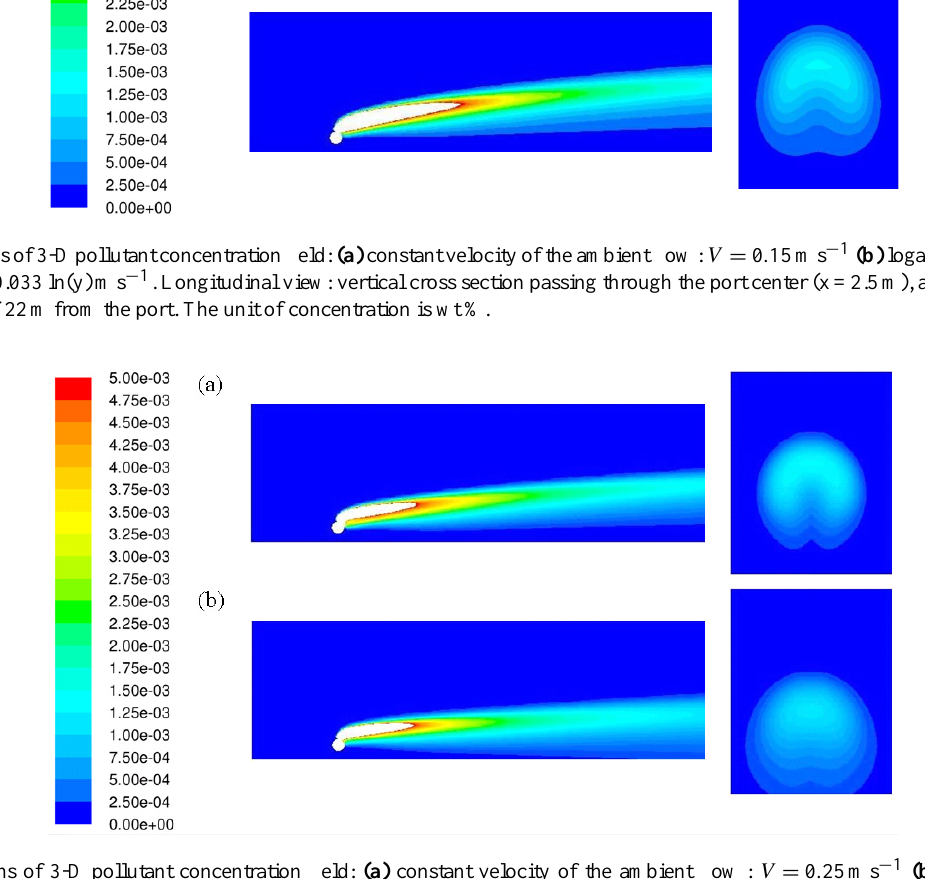
Fig. 5. Projections of 3-D pollutant concentration field: (a) constant velocity of the ambient flow : V = 0 . 25ms − 1 (b) logarithmic BBL profile V (y) = 0 . 241+0.049 ln(y)ms. Longitudinal view: vertical cross section passing through the port center (x=2.5m) and transversal view at a z-distance of 22m from the port. The unit of concentration is wt